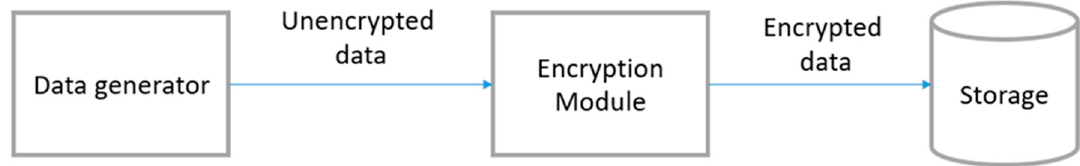
Figure 3. Descriptive overview of the Encrypted Storage pattern.